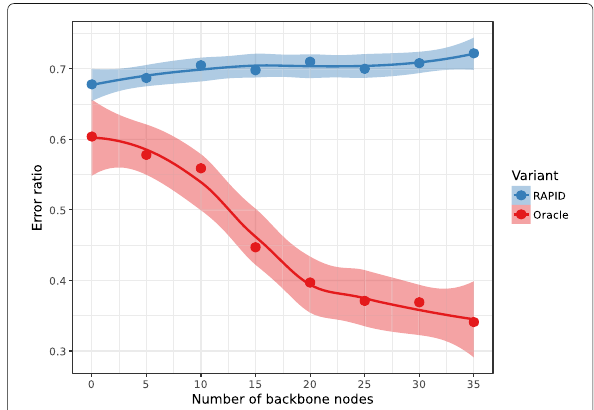
Fig. 2 Gap between current DTN protocol performance and ideal result [5]